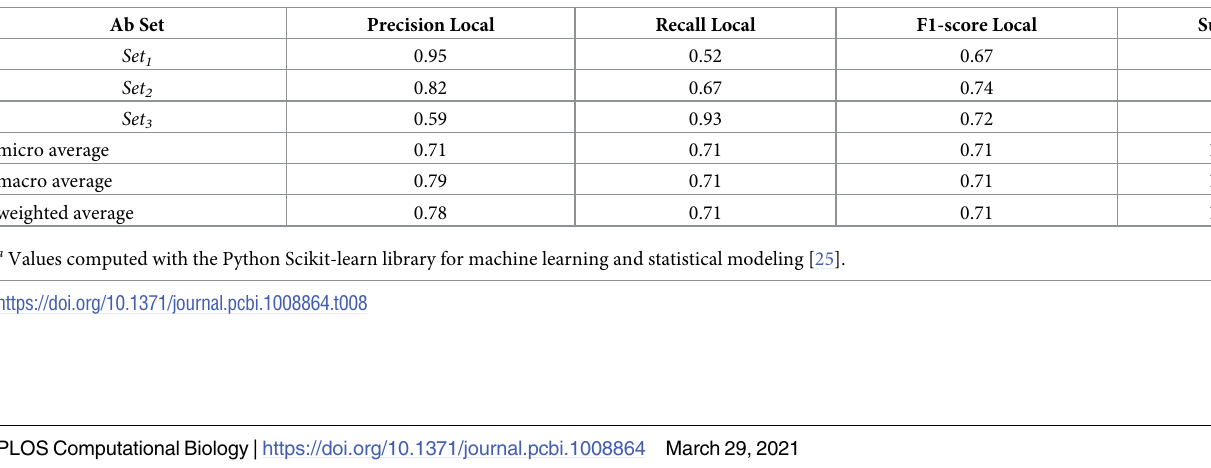
Table 8. Classification of 30 Abs that bind exclusively to one out three possible epitopes in the EBOV GP trimer. Summary statistics a of 20 DNN models trained using fingerprints colored according to the charge coloring